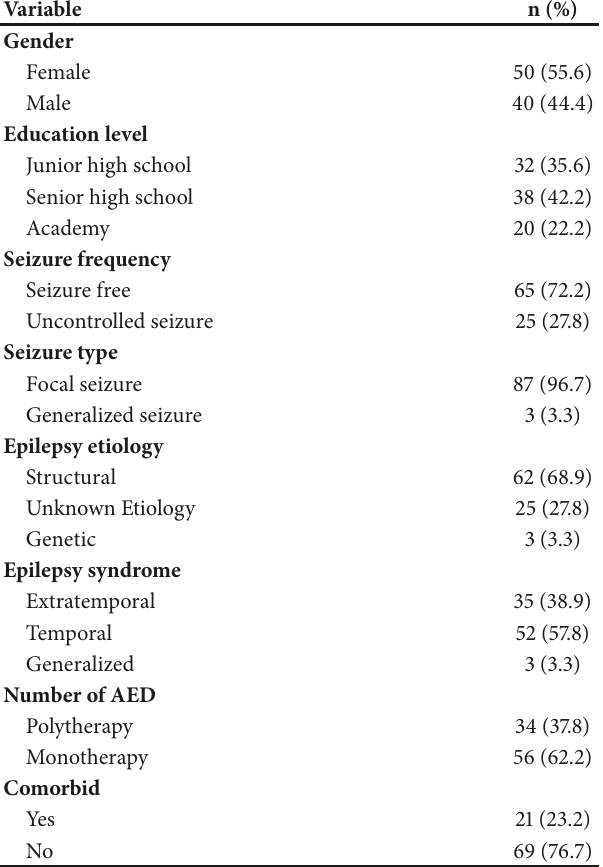
Table 2: Subjects Demographic and Clinical Characteristic (n=90).